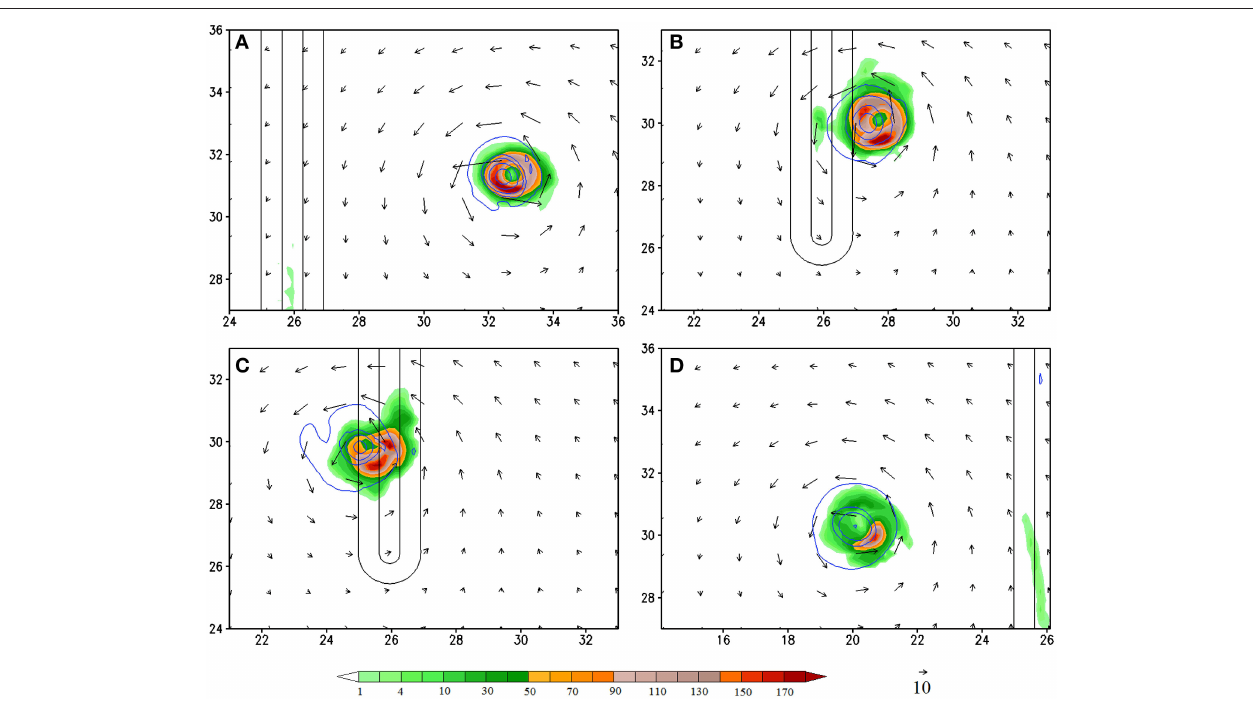
FIGURE 8 | (CNTL/A2) Accumulated 3h rainfall (shaded, in mm/3 h) at (A) 132h, (B) 168h, (C) 180h, and (D) 216h. The units of the coordinates in the x and y directions are 100 km. The relative vorticity fields are depicted by contours (0.0001, 0.0005, 0.001, 0.002, 0.003 s − 1 ).